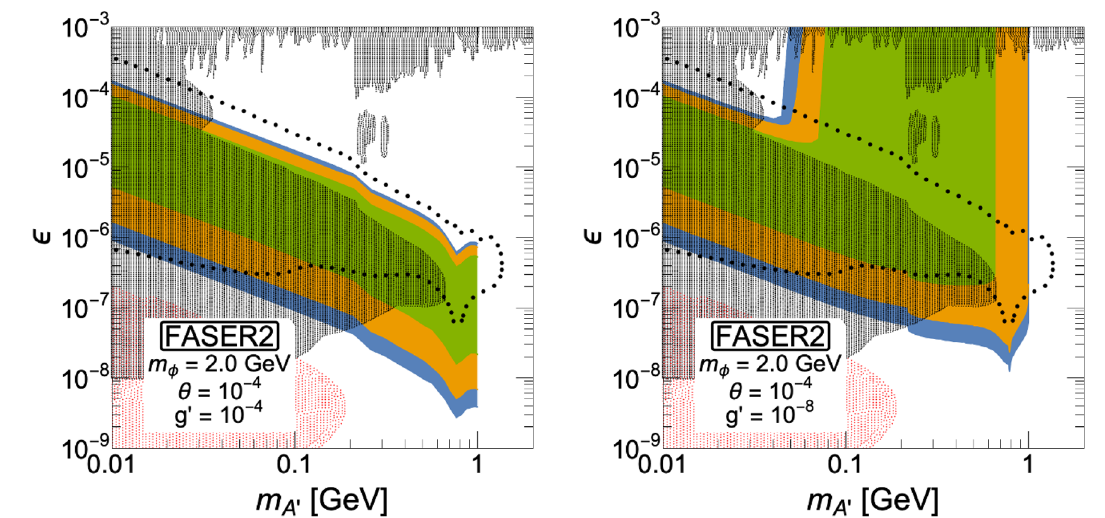
Figure 2 . Expected number of the signal events of the dark photon from the scalar boson de- cays in FASER 2. Blue, orange, and green regions correspond to 3–9, 10–99, and ≥ 100 events, respectively. Gray and pink shaded regions show the parameter spaces which are excluded by the current experiments [18] and supernova cooling [34], respectively. Black dots show the projected dark photon sensitivity reaches at 95 % C.L. in refs. [3,